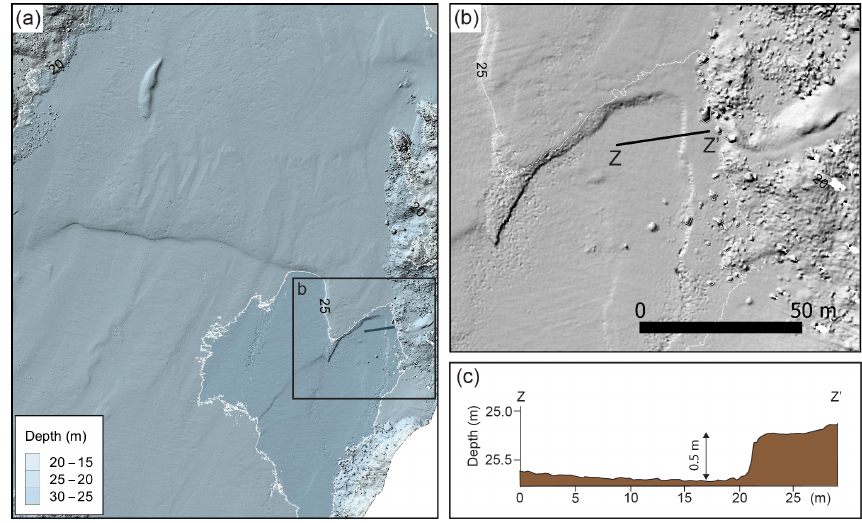
Figure 4. Multibeam bathymetry of a terrace mapped in the southern Blekinge archipelago. (a) Only a smaller part of the full survey is shown without coordinates because detailed bathymetric information from this area is under military restrictions. (b) Detail of the > 500m long terrace with the location of the bathymetric profile from Z − Z (cid:48) shown in (c) .